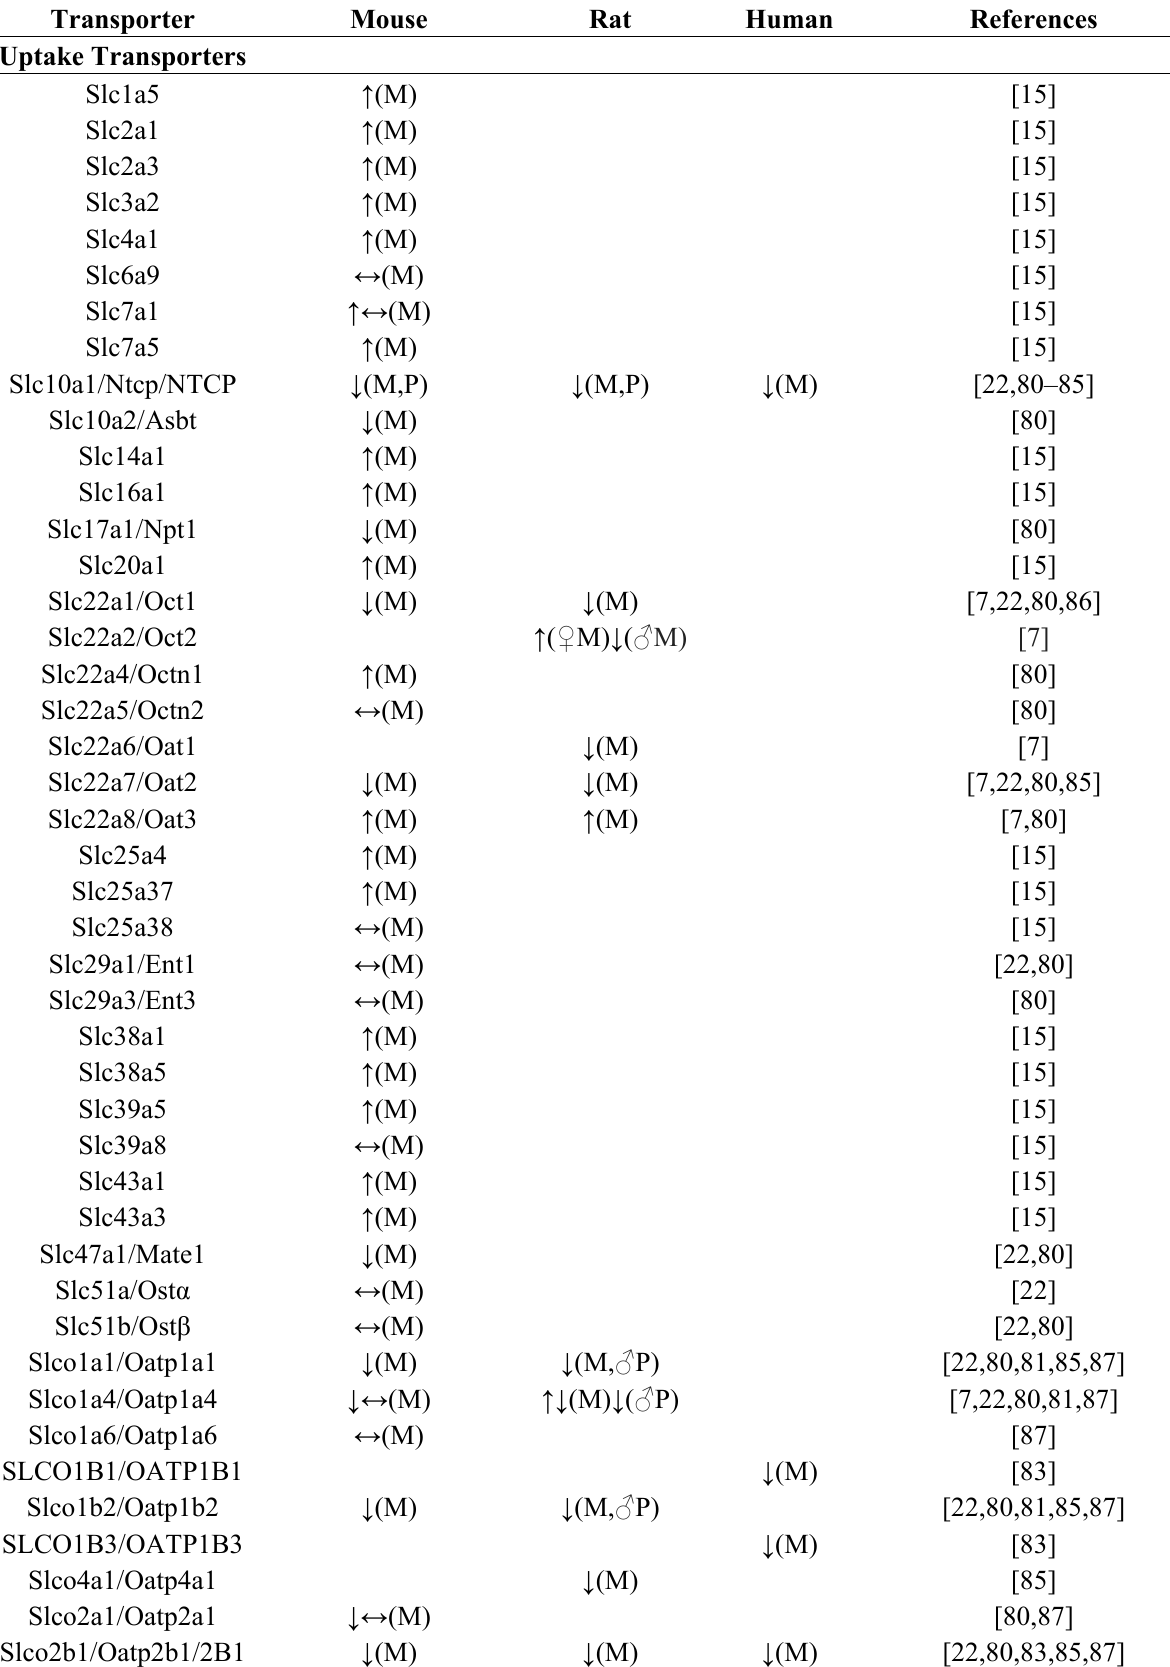
Table 4. Transport in rodent and human fetal livers.